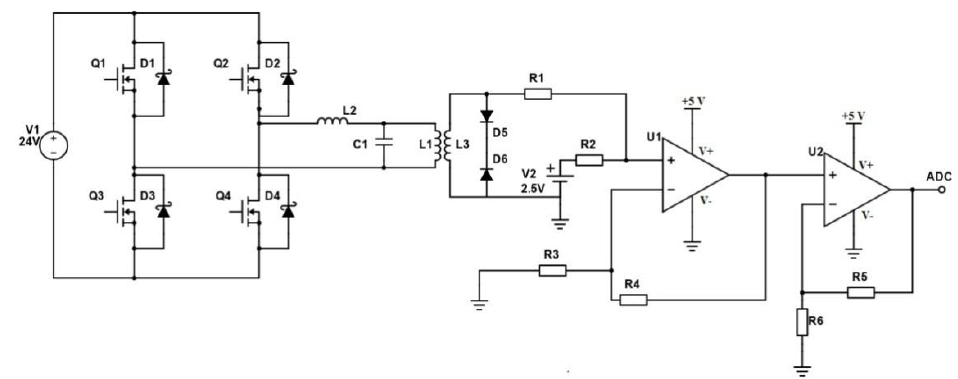
Figure 6. High-frequency induction heating system with LCL-resonant output and Sensing circuit.